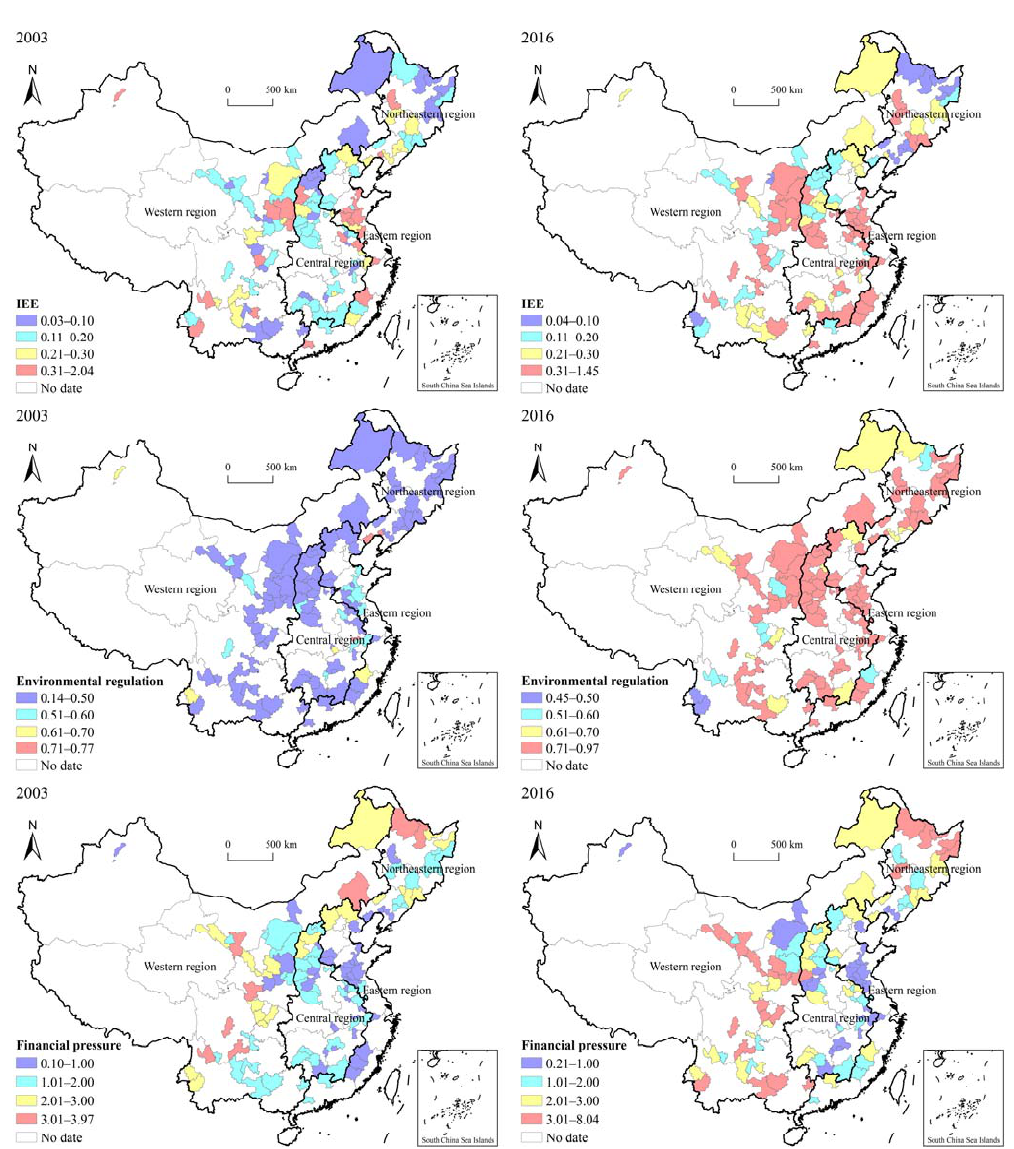
Figure 4. Spatial pattern of IEE, environmental regulation, and financial pressure in China’s RBCs.